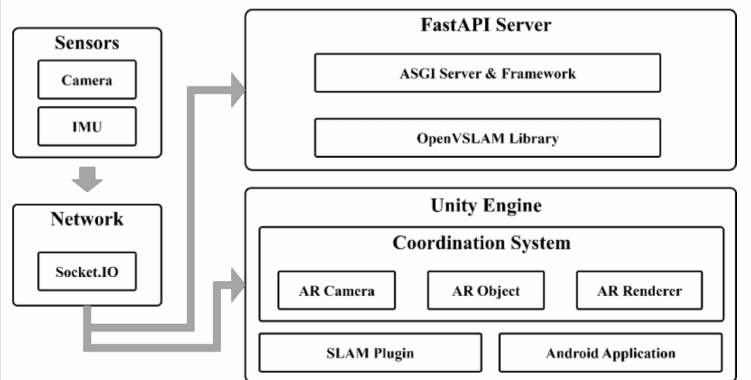
Figure 3. Integrated mobile SLAM architecture of stand-alone type and mapping server type.